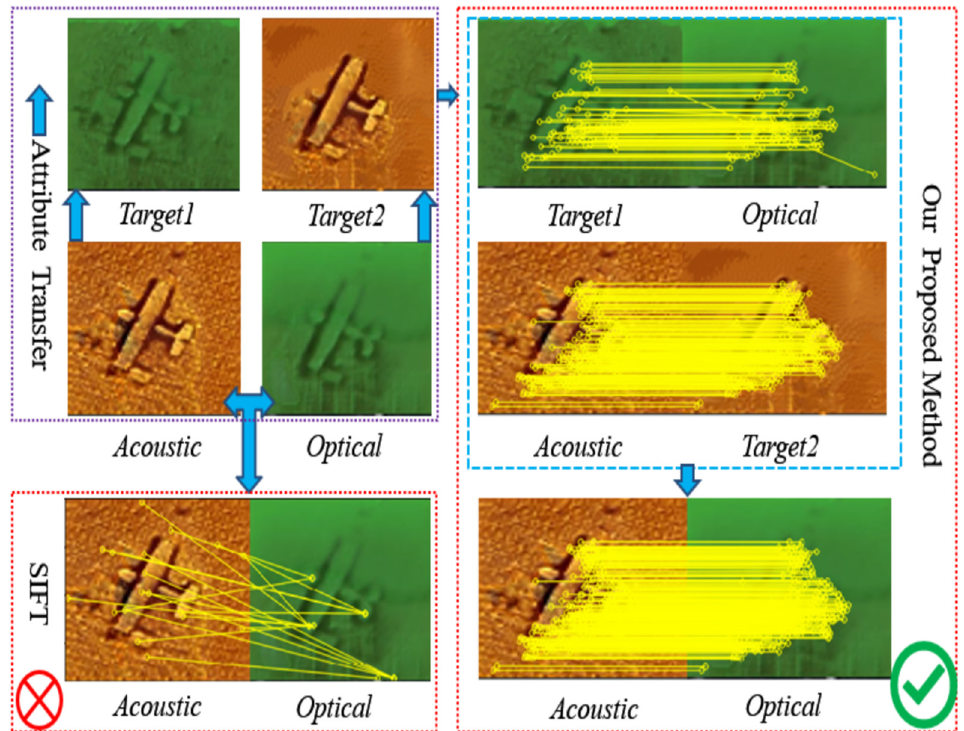
Figure 1. The process of the proposed